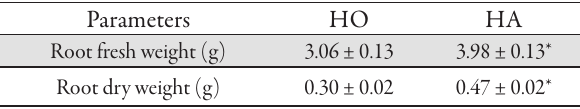
Tab. 3. The effect of humic acid on broad bean ( Vicia faba L.)